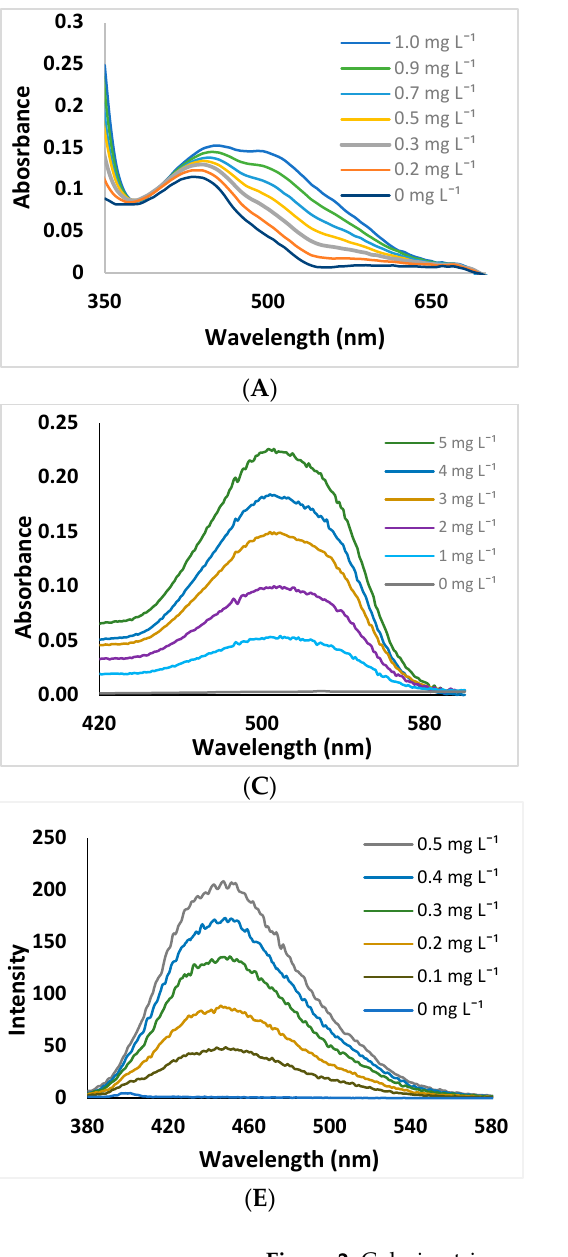
Figure 2. Colorimetric measurements: Absorption spectra obtained with: ( A ) after preconcentration procedure from norfloxacin solutions and ( C ) allura red solutions. Calibration curves obtained using the proposed system: ( B ) norfloxacin solutions and ( D ) allura red solutions. Fluorimetric measurements: ( E ) emission spectra of quinine solutions and ( F ) calibration curve obtained using the proposed system. Error bars represent standard deviation ( n =